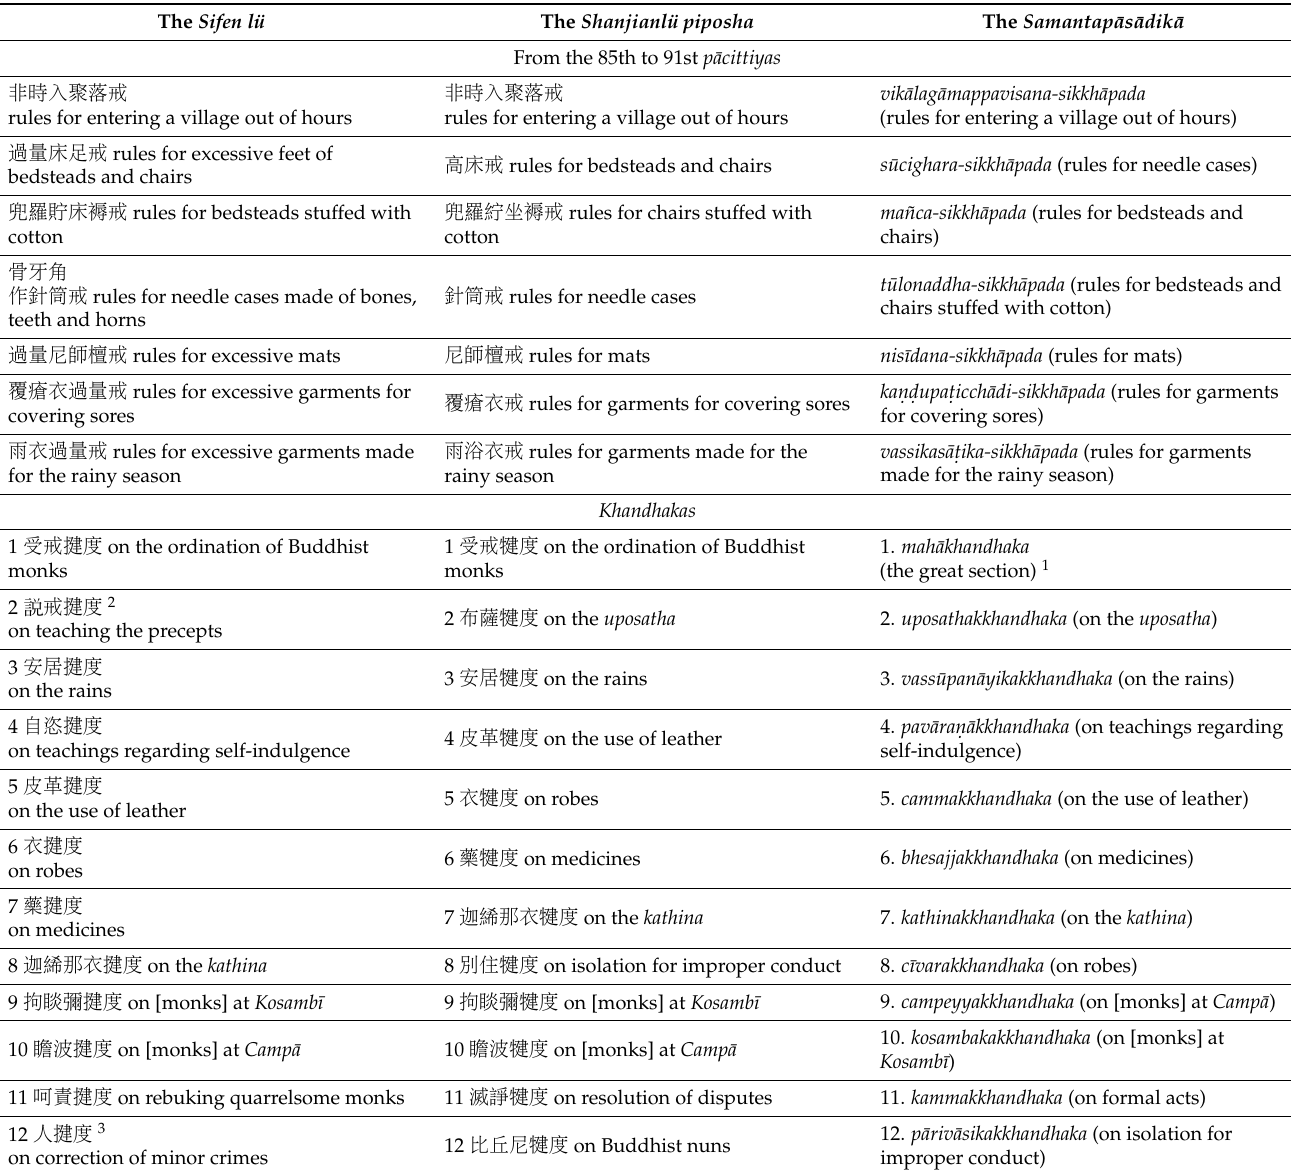
Table 2. A comparison of the ordering of the 85th–91st p¯acittiya s and khandhaka s in the Sifen lü , Shanjianlü piposha , and Samantap¯as¯adik¯a